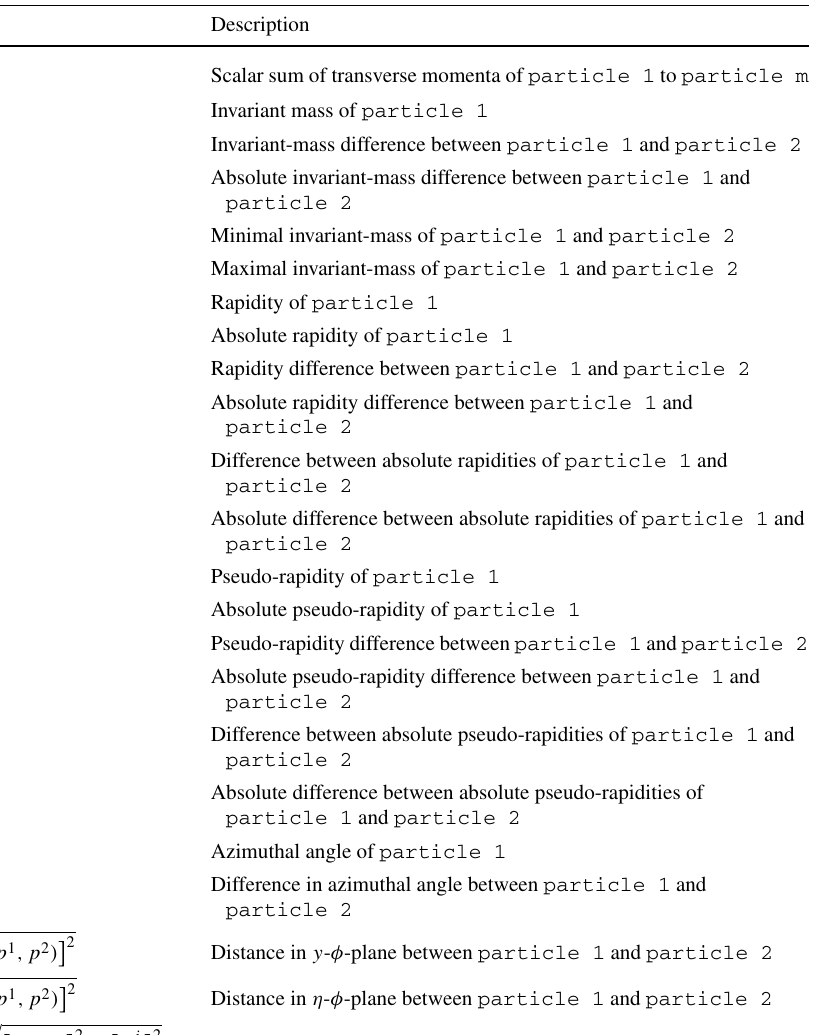
Table 4 Predefined distributions available in Matrix . These dis- tributions can be used in a distribution block of the file distribution.dat and require to specify the parameter(s) particle j , j = 1 ,..., m ( m ≥ 1). Some observables behave differently for a different number of defined particles m : In these